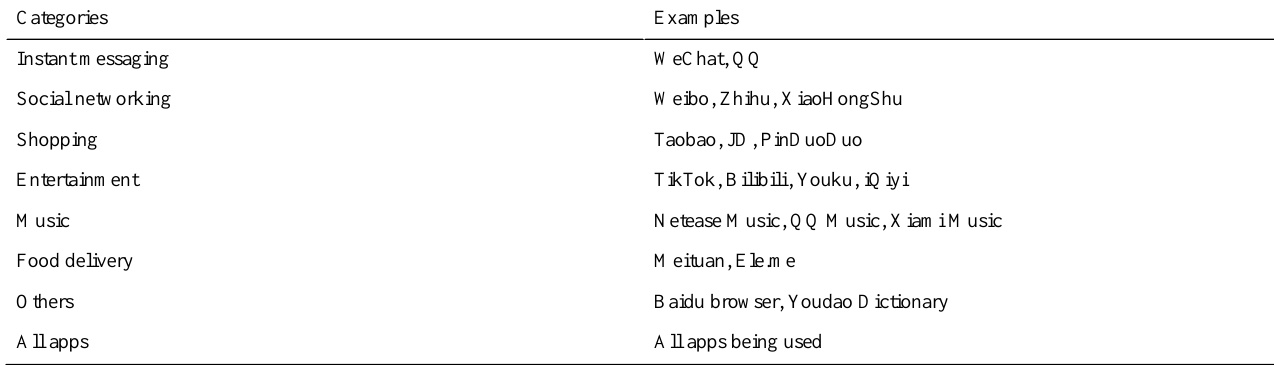
Table 2. Apps categories and